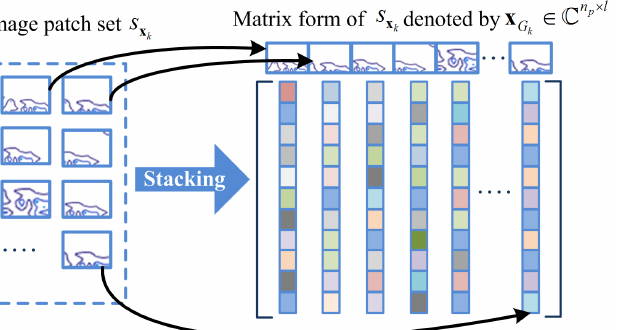
Figure 2. Reshape each patch in s x the image patch group x G